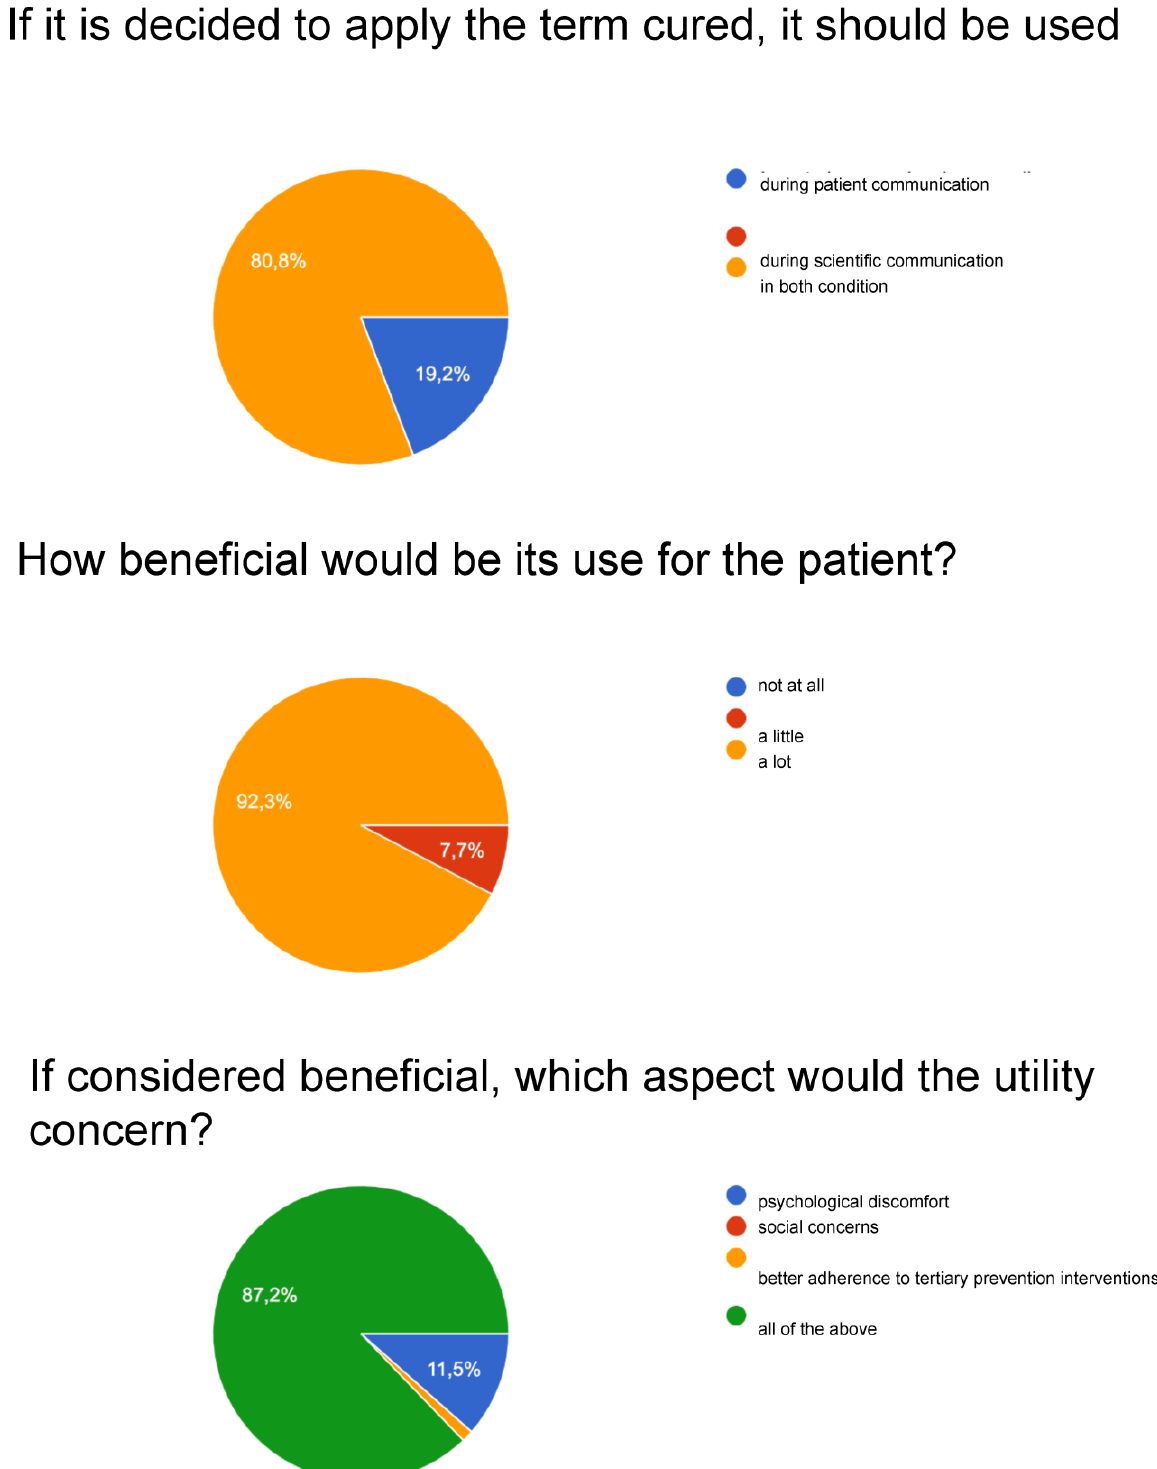
Figure 1. Radiotherapists. Figure 1.